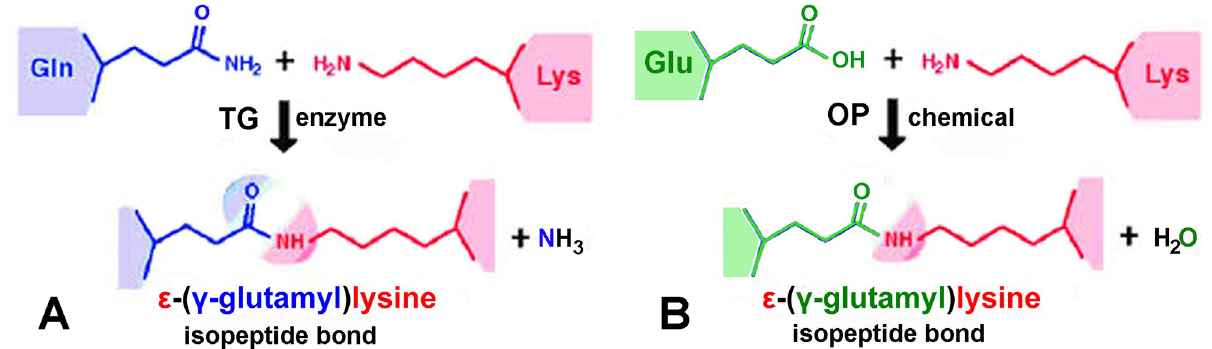
Fig 1. A) Isopeptide bond between glutamine and lysine formed by the action of the transglutaminase (TG) enzyme with release of ammonia. B) Isopeptide bond between glutamic acid (or aspartic acid) and lysine formed by exposure to organophosphorus chemicals (OP) with release of water. Figure adapted from